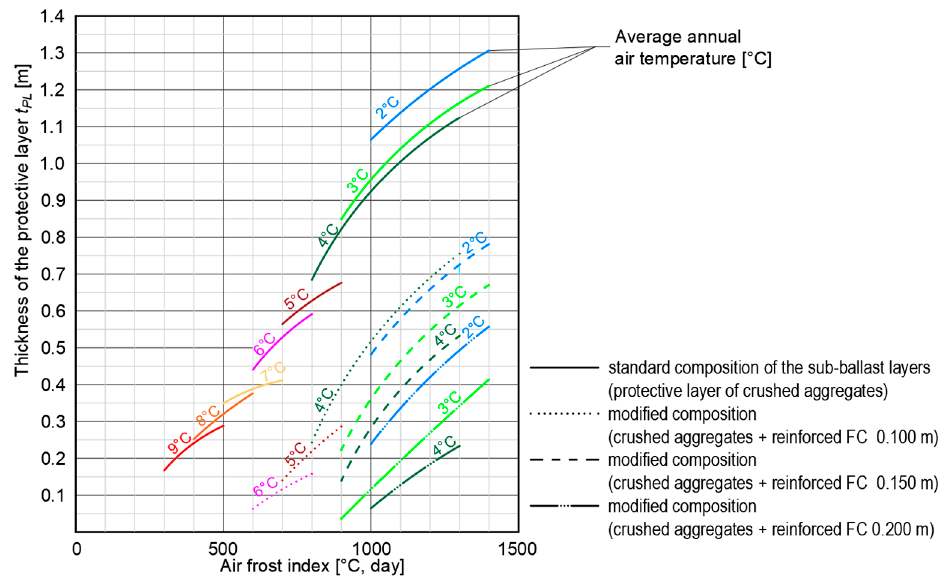
Figure 15. Design nomogram—dependence of the thickness of the protective layer made of crushed aggregate on the climate conditions for the railway sub-ballast layers with the built-in thermal insulation layer made of composite FC.